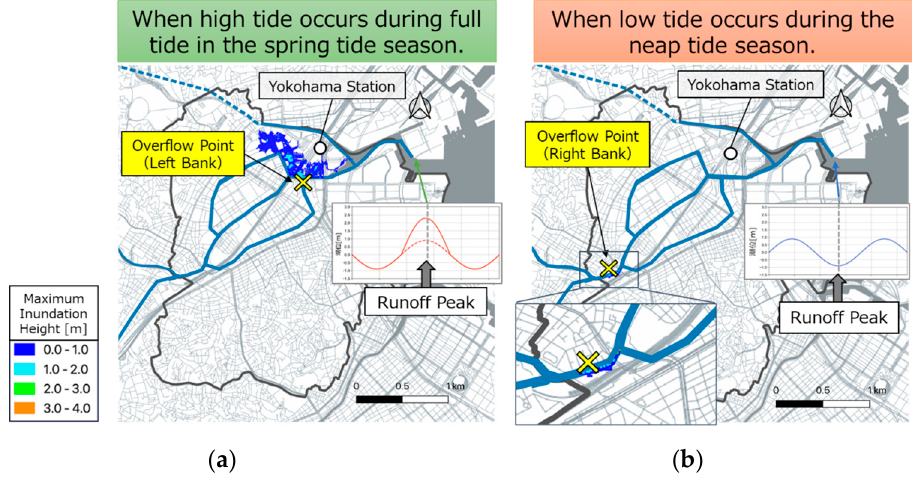
Figure 13. Comparison of the maximum and minimum inundation situations obtained through river water flooding analysis: ( a ) when high tide occurs during full tide in the spring tide season; and ( b ) when low tide occurs during the neap tide season.